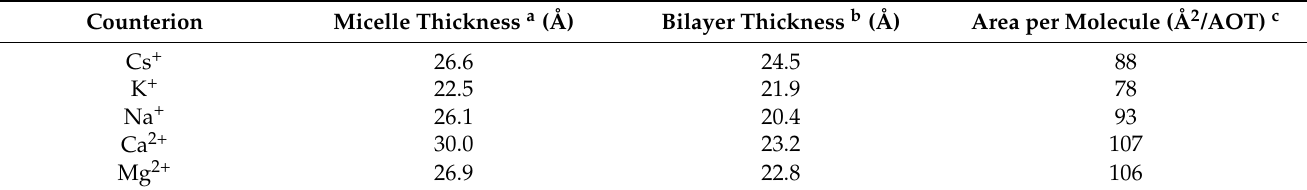
Table 1. AOT Layer Thickness and Surface Coverage from MD